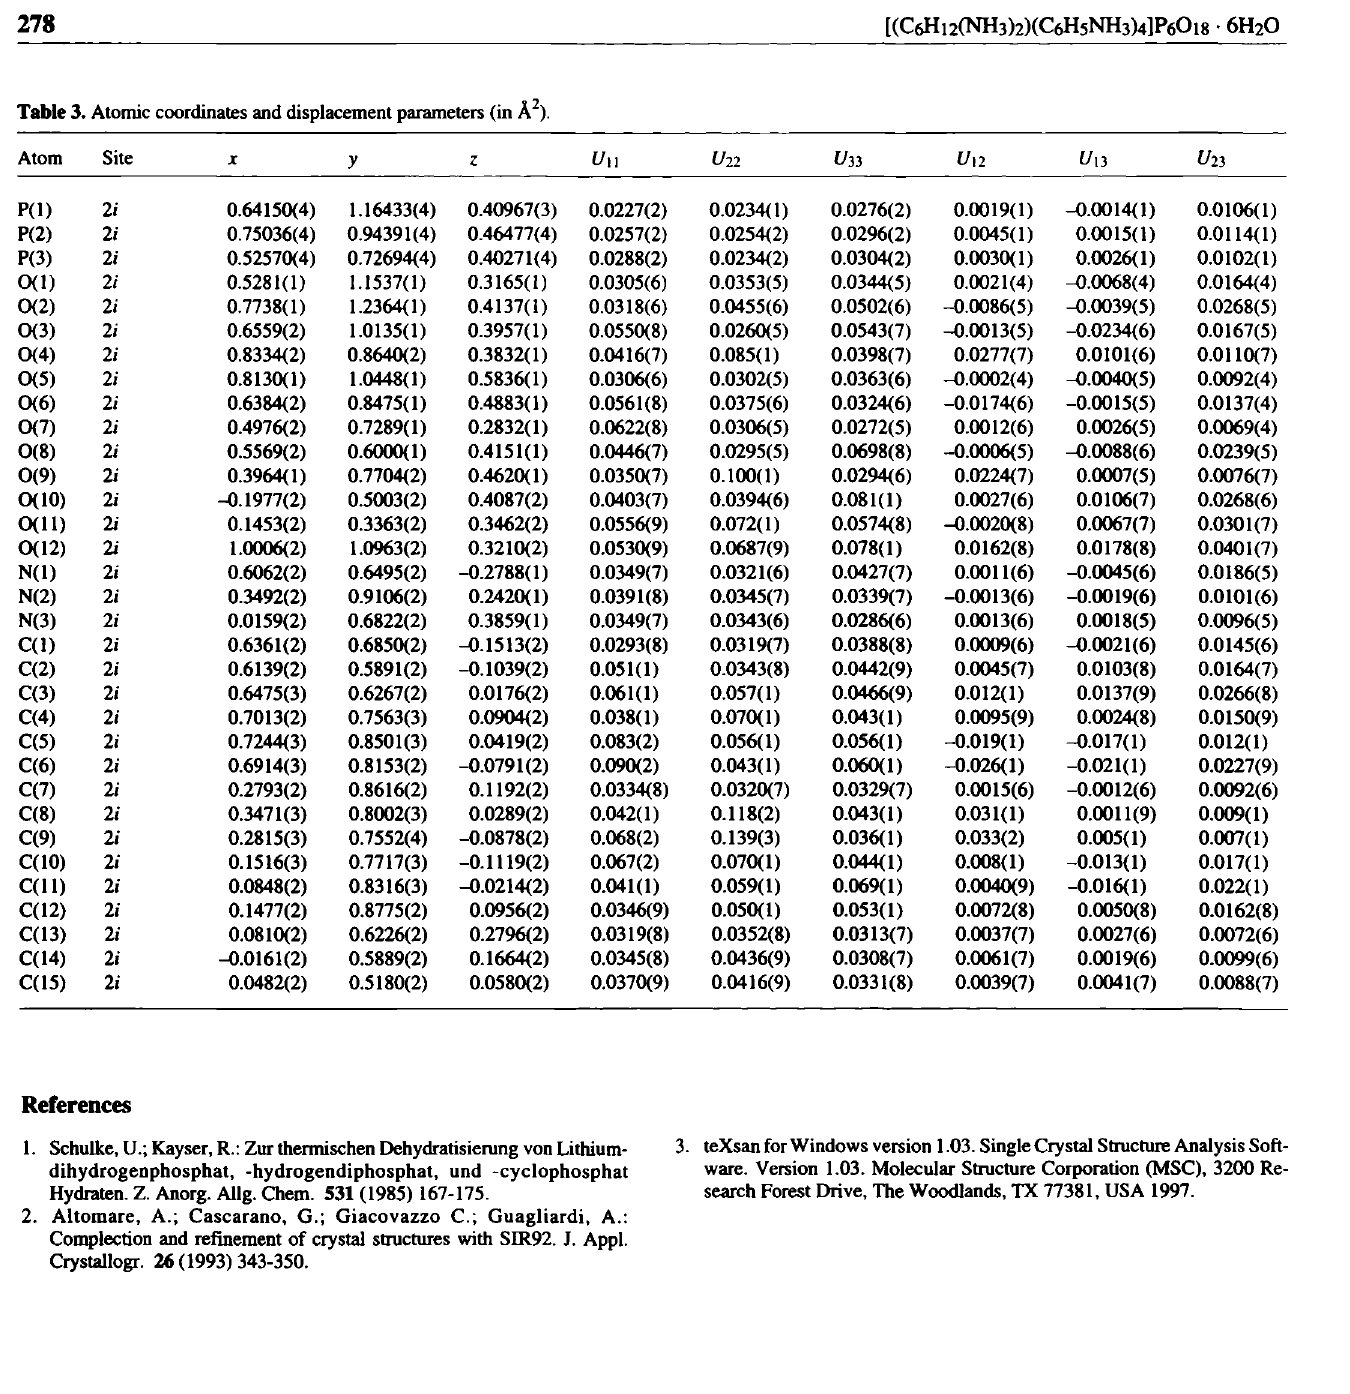
Table 3. Atomic coordinates and displacement parameters (in Â 2